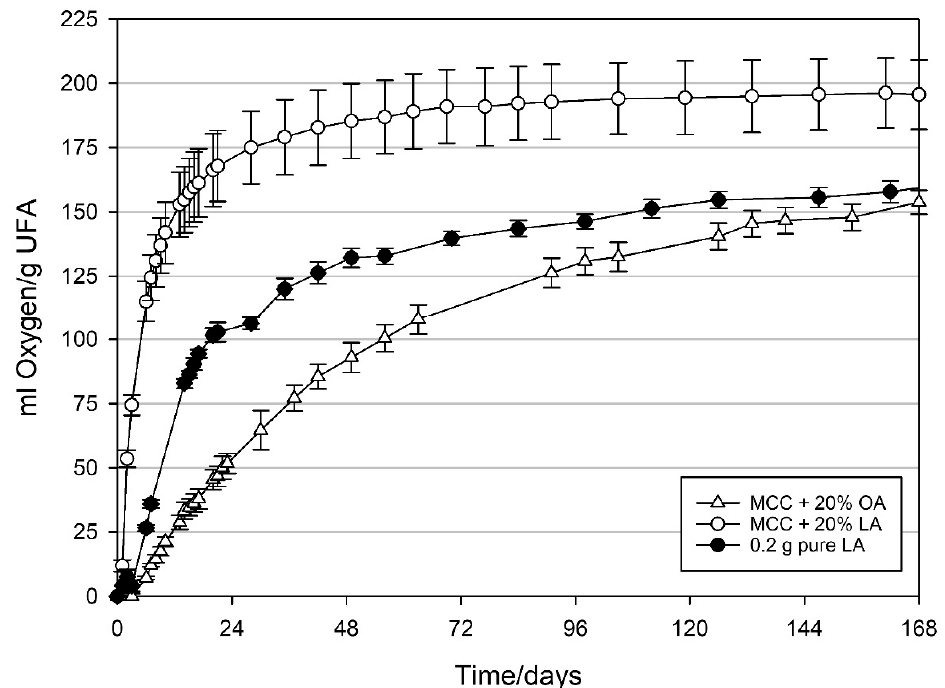
Figure 9. Oxygen absorption capacity of oleic and linoleic acid measured in packages containing 1 g modified calcium carbonate (MCC) loaded with 20 wt% oleic acid and linoleic acid, and 0.2 g pure linoleic acid. Packed under normal atmosphere (NA; headspace 250 mL), ~50% RH in the package and stored at 21 °C. Mean values and standard deviation (n = 4).